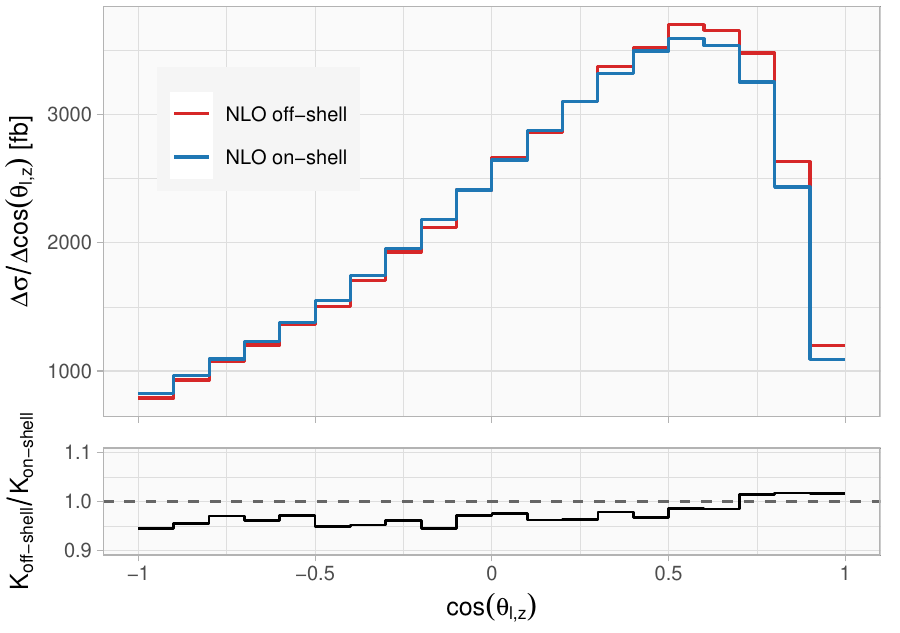
Figure 16. Distribution of cos (cid:18) l;z at NLO in the on-shell approximation and for an o(cid:11)-shell top quark. The lower panel shows the ratio of the o(cid:11)-shell and on-shell K -factors. Note the range of the y -axis, which does not start at zero.